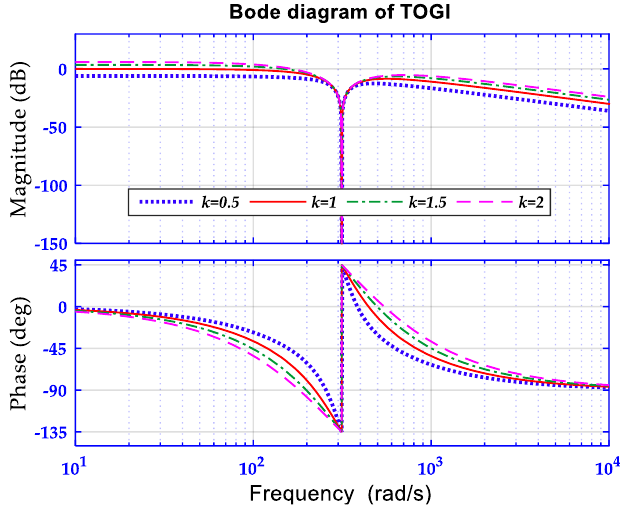
( ) TOGI s . Figure 4. Bode diagram of the third-order transfer function TOGI ( s )